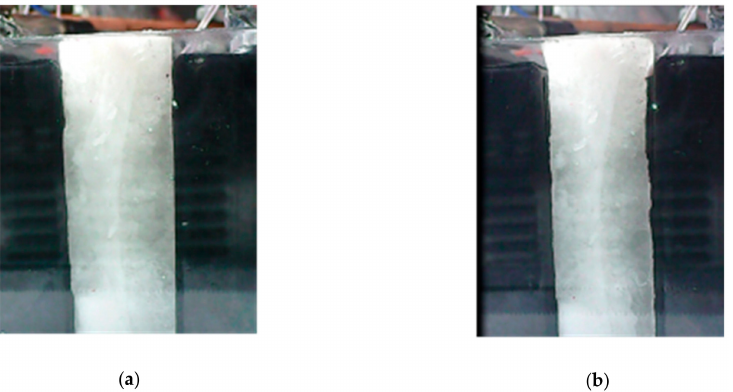
Figure 7. Image of pure para ffi n melting under 1.5C discharge rate: ( a ) Before absorbing heat; ( b ) After heat